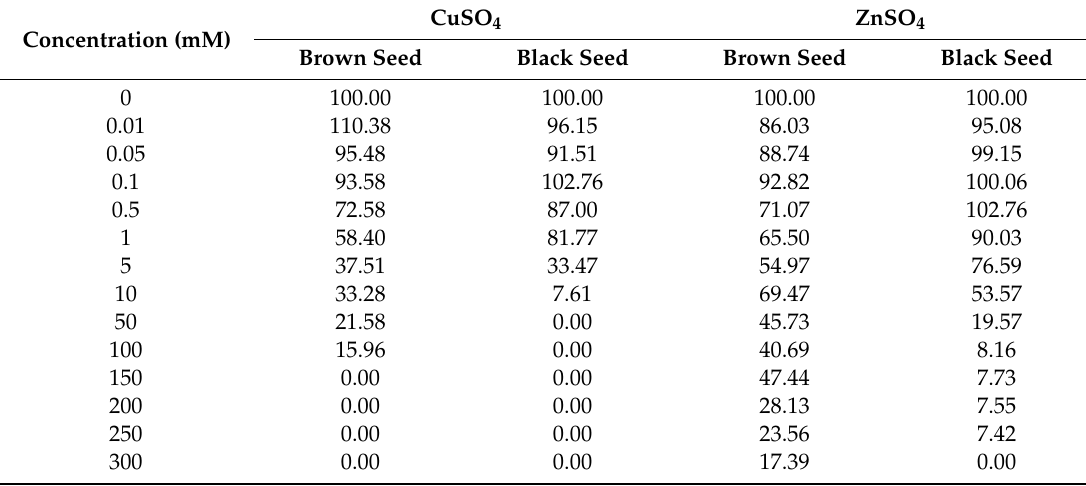
Table 5. E ff ect of CuSO 4 and ZnSO 4 on shoot tolerance index of S. salsa seedlings grown from brown and black